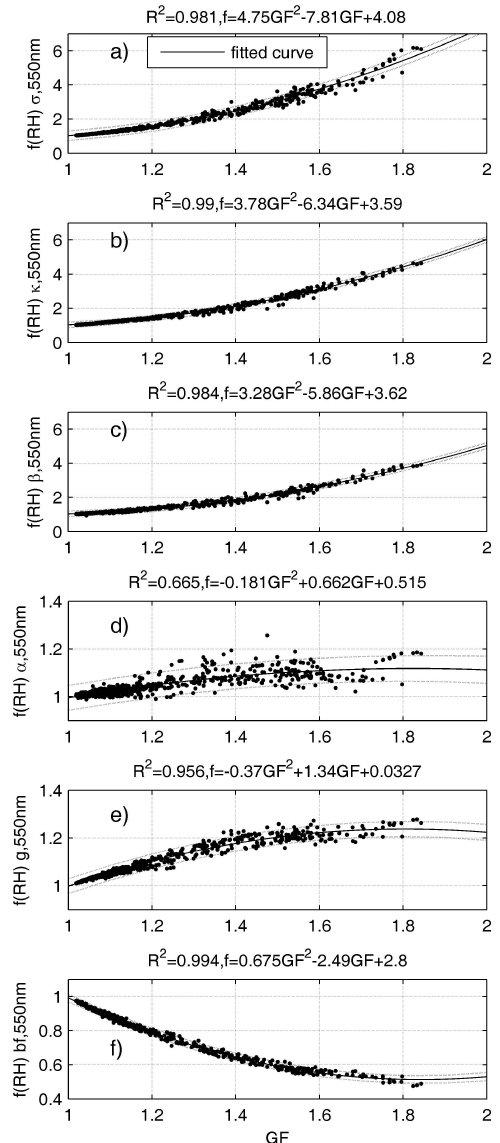
Fig. 9. Regression analysis between enhancement factors f (RH) and GF(RH), at 550nm, for scattering coefficient (a) , extinction co- efficient (b) , backscatter coefficient (c) , absorption coefficient (d) , asymmetry parameter (e) and backscatter fraction (f) . The dotted curves represent the 95% confidence level of the fitted curves.